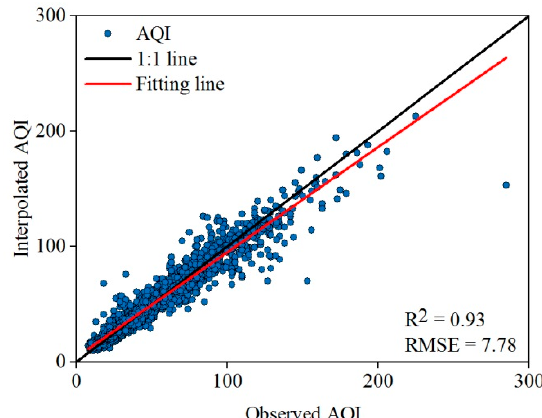
Figure 2. Comparison between observed hourly AQI and interpolated hourly AQI.